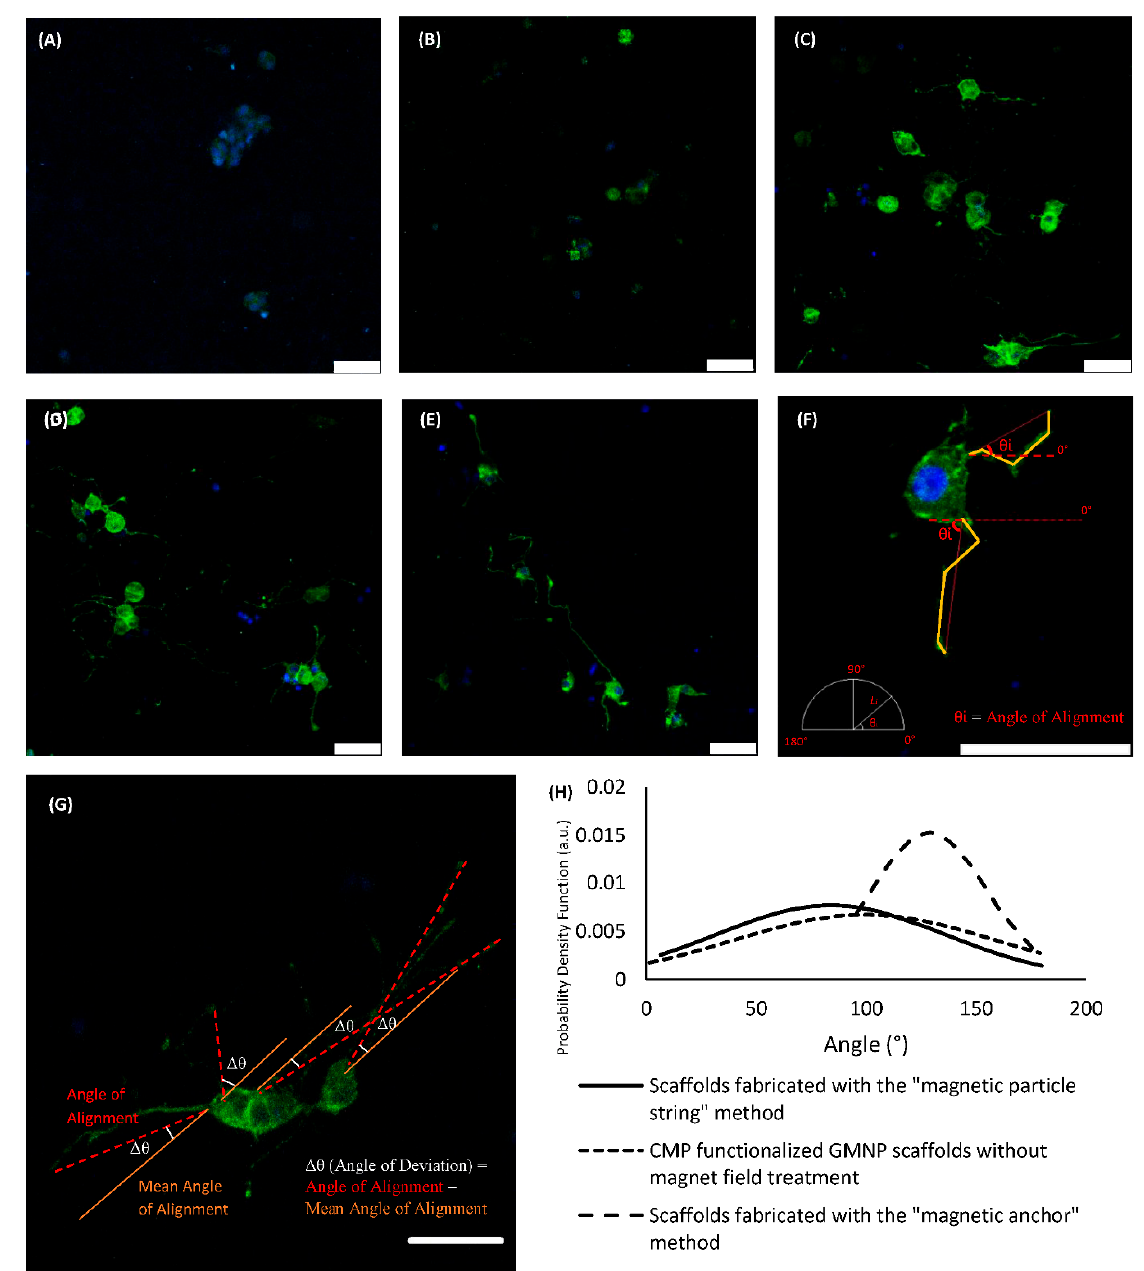
Figure 5. Confocal images of Phalloidin/DAPI staining of PC12 cells within plain collagen scaffolds ( A ), GMNP-incorporated collagen scaffolds without magnetic field treatment ( B ), scaffolds fabricated with the “magnetic particle string” method ( C ), CMP-functionalised GMNP collagen scaffolds without magnetic field treatment ( D ), and scaffolds fabricated with the “magnetic anchor” method ( E ). Image ( F ) shows the method in which the differentiated PC12 cells were measured; the yellow lines indicate the axonal length and red lines indicate the plane of alignment. θ represents the angle of alignment calculated from the horizontal plane (0°). ( G ) shows the method to derive the angles used in this analysis. ( H ) shows the alignment of axons represented by normal distribution curves for treatments that showed axonal growth. Scale bar = 50 µm.